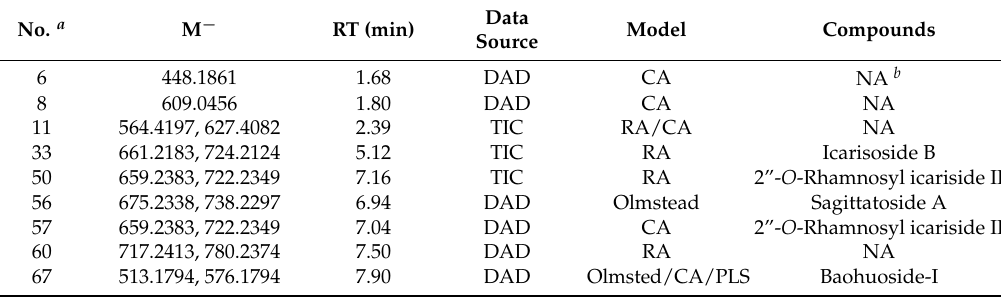
a Number of selected features from 73 features extracted from DAD; b NA means unknown